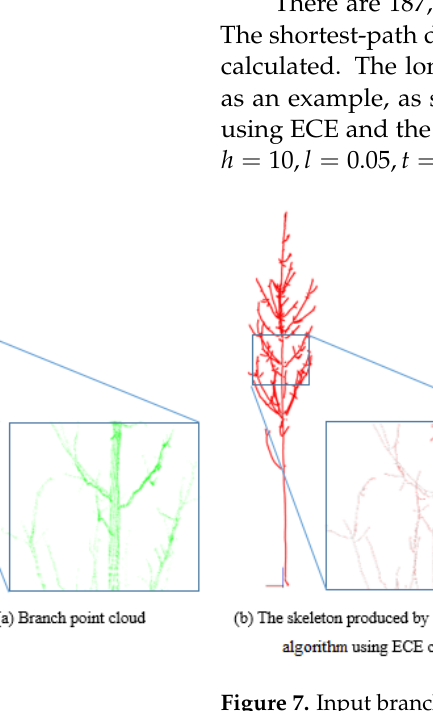
Figure 7. Input branch point cloud and skeletons with different clustering